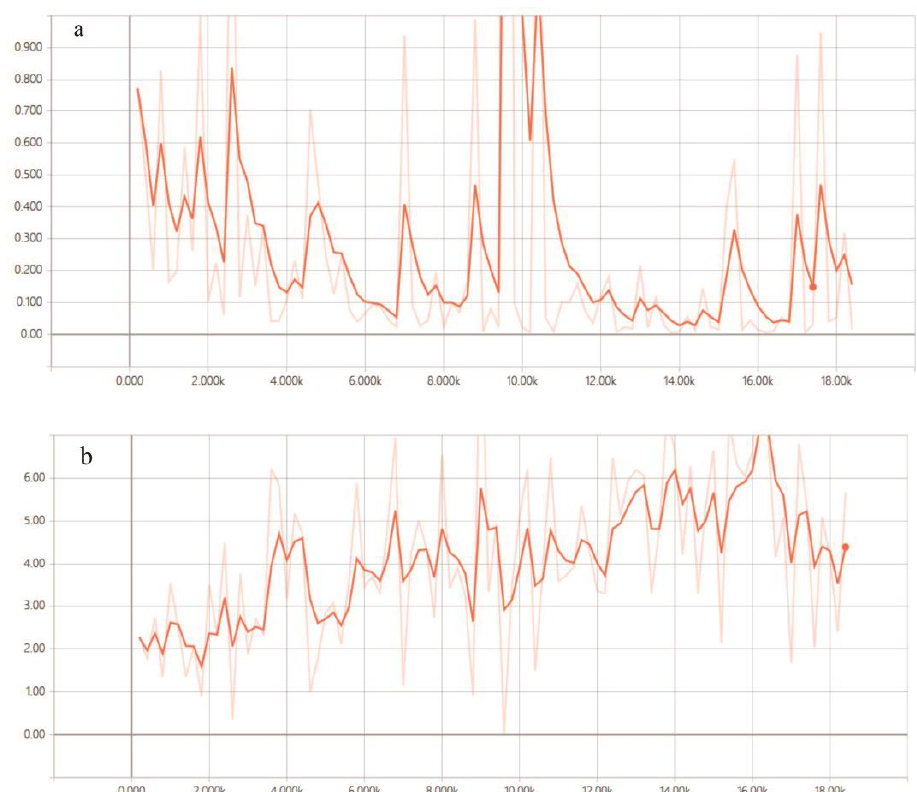
Figure 8. Loss curves during CGAN training. ( a ) Discriminator D loss curve; ( b ) generator G loss curve.